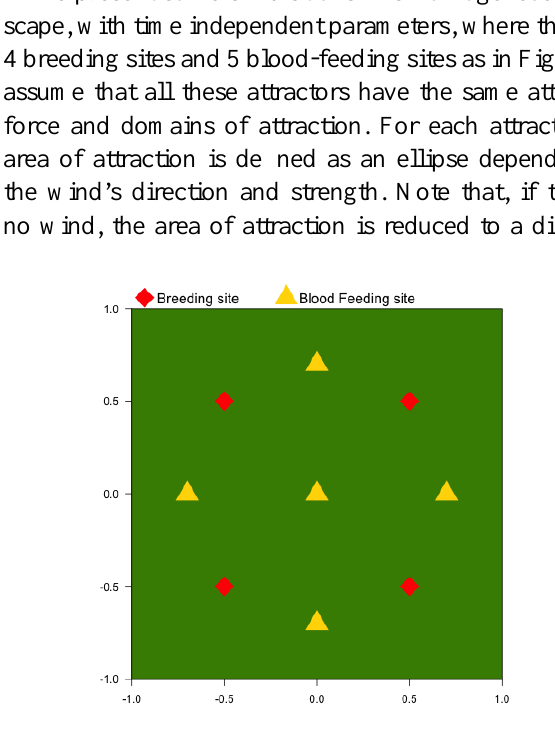
Fig. 1. Homogeneous landscape with 5 houses (blood meals) and 4 breading sites When the landscape is homogeneous, without wind, the mature females, i.e., the blood feeding females,